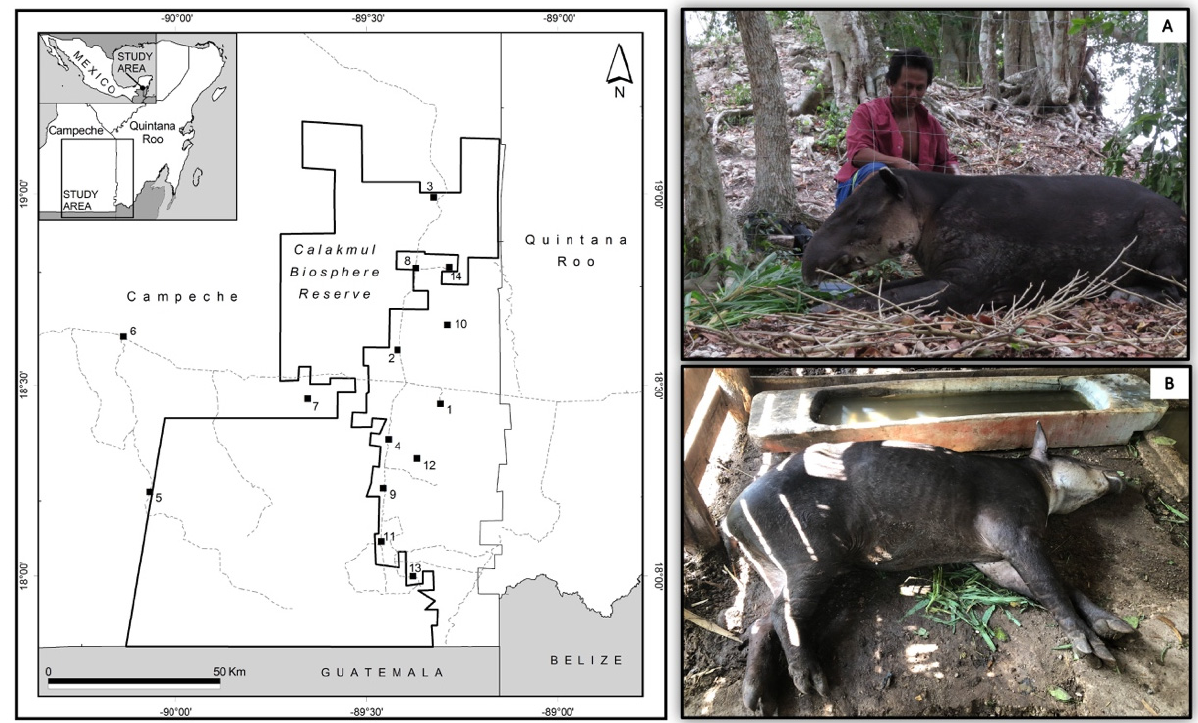
Figure 1. Location of the 14 settlements where Baird’s tapirs ( Tapirus bairdii ) were sighted during 2008 to 2019 in the municipality of Calakmul, Campeche, Mexico. (1) 20 de Noviembre, (2) Alvaro Obregón, (3) Bel-ha, (4) Castilla Brito, (5) Concepción, (6) Constitución, (7) Emiliano Zapata, (8) Nueva Vida, (9) Narciso Mendoza, (10) Nuevo Becal, (11) Once de Mayo, (12) El Refugio, (13) Sacrificio, and (14) Unión 20 de Junio. ( A ) People caring for a tapir injured by a jaguar in the community of Nueva Vida; and ( B ) Tapir resting in a pen in the community of Bel ha.